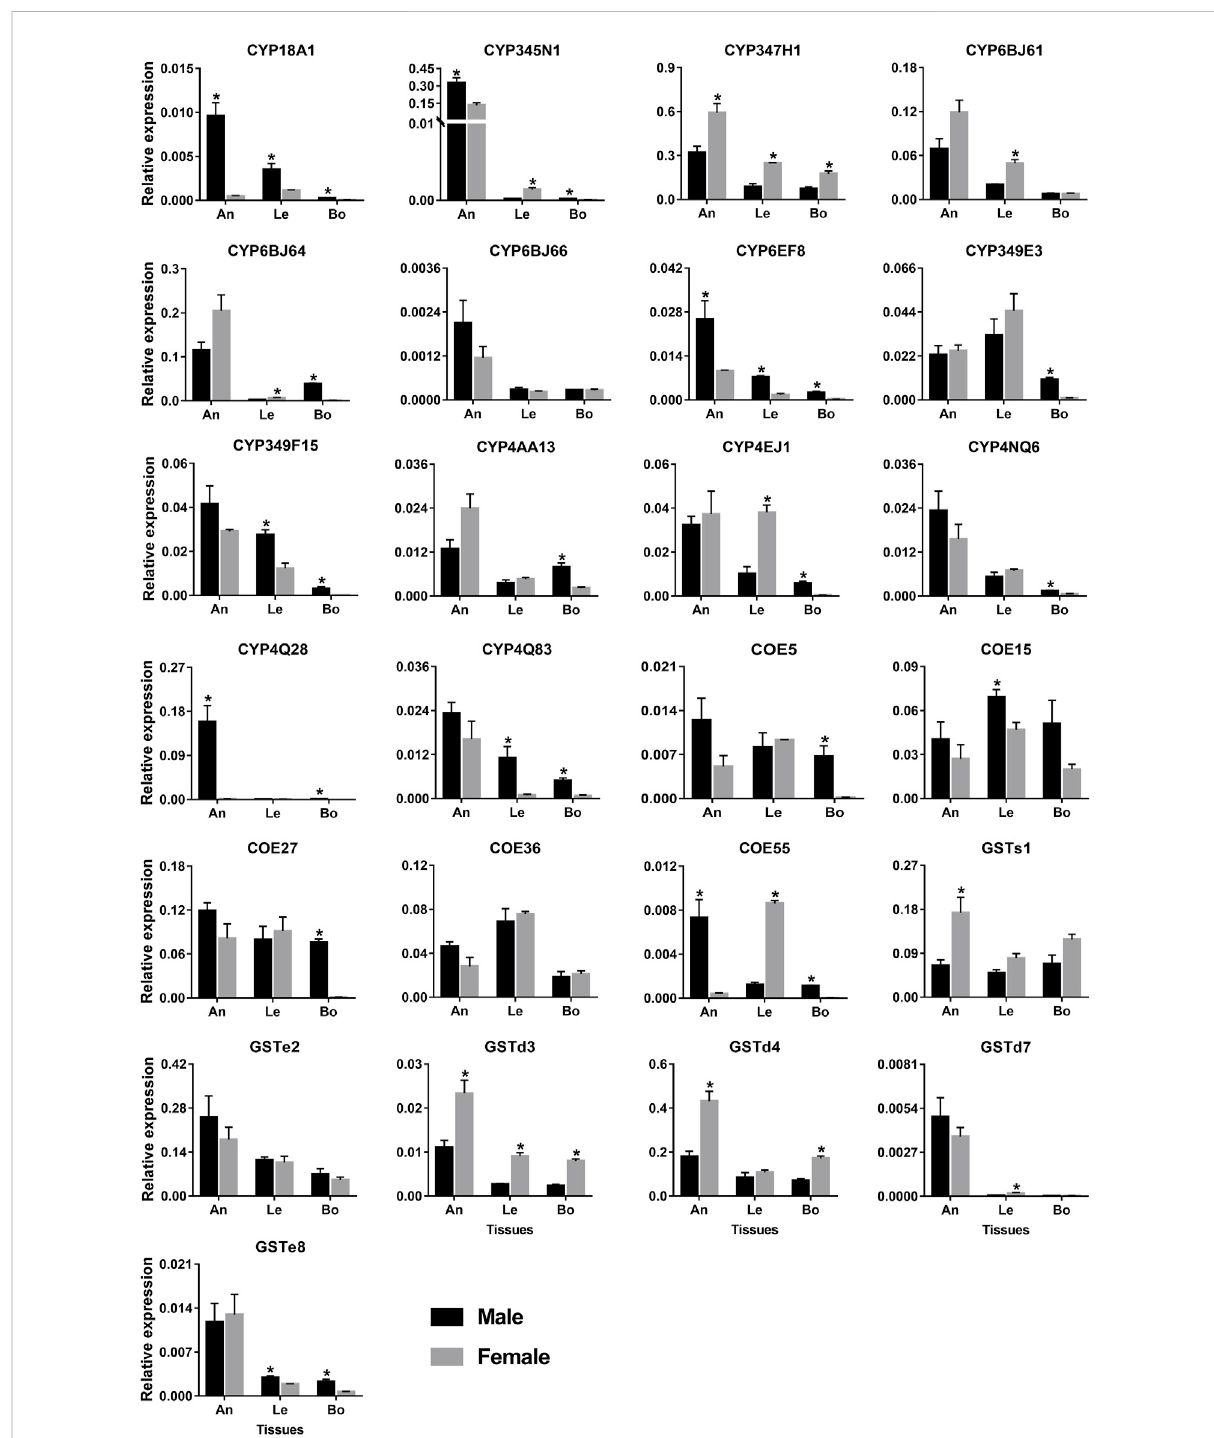
FIGURE 9 qPCR analysis of 25 detoxi fi cation genes in various tissues of P. antennata . Data denote mean ± standard errors. Asterisks represent signi fi cant differences between male and female tissues (ANOVA, Student ’ s t – test, p < 0.05). An, antennae; Le, legs and Bo, bodies without antennae and